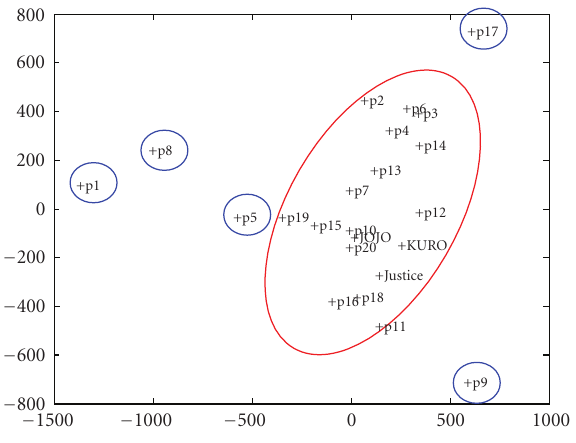
Figure 12: MDS result for all data.